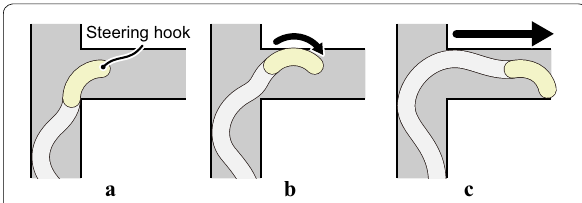
Fig. 8 Strategy for maneuvering the steering hook into a branched pathway at Type B branch. a Device approaches a branch, keeping the steering hook facing the branch. b Steering hook catches a corner of the branch, allowing it to enter the branched pathway. c Device follows the steering hook into the branch